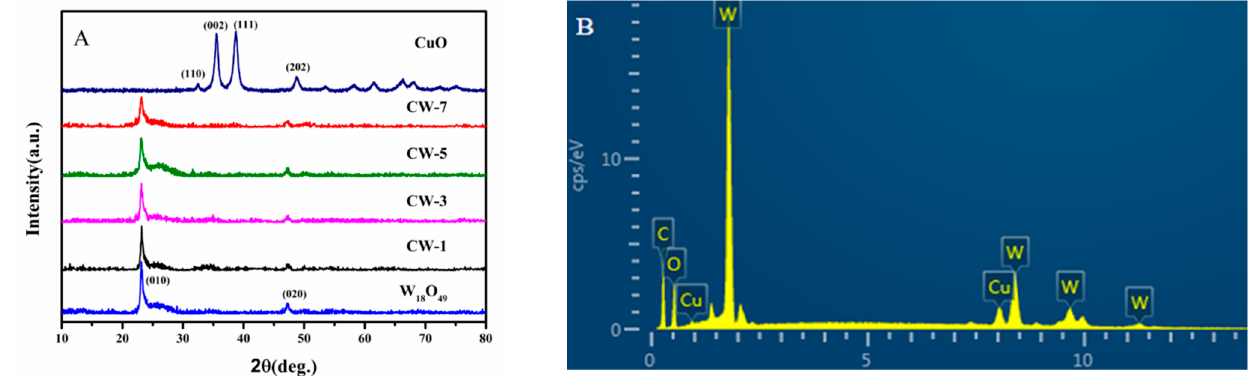
Figure 1. ( A ) XRD patterns of W 18 O 49, CuO and CuO/W 18 O 49 samples with different contents of CuO; ( B ) the EDX spectrum of CW-5.